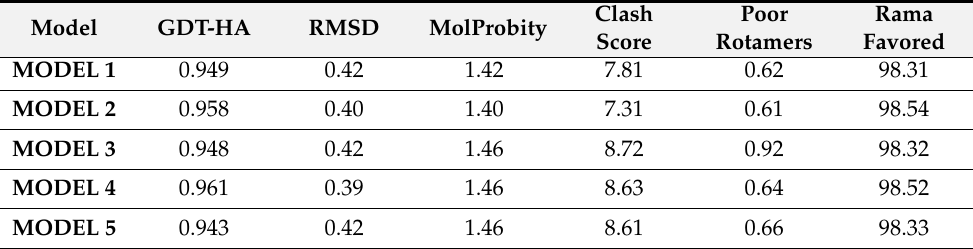
Table 5. The tertiary structure of the vaccine was refined using the GalaxyRefine server, and Model 2 was selected due to its good Rama favored score of 98.54 and low mol probity of